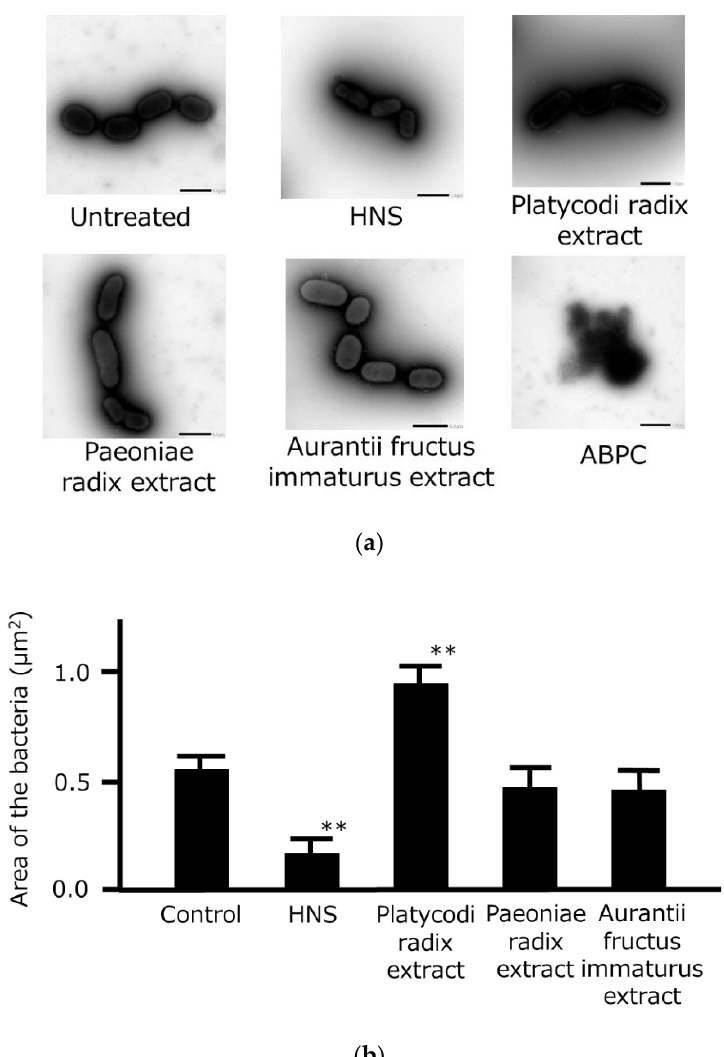
Figure 4. Morphological changes in Porphyromonas gingivalis following treatment with the three components of HNS. ( a ) Representative photographs of P. gingivalis following treatment with HNS, the extract of one of the three components of HNS (500 µ g / mL), or ampicillin sodium (ABPC; 50 µ g / mL) for 48 h, viewed under a transmission electron microscope with negative staining. Bars represent 1 µ m. ( b ) Area of P. gingivalis treated with HNS, the extract of one of the three components of HNS (500 µ g / mL), or ABPC (50 µ g / mL) for 48 h. The area was measured at 5 arbitrary points in bacteria treated with the crude drugs. Data represent means ± SD ( n = 5). ** p < 0.01 vs. the control group (Tukey’s multiple comparison test).